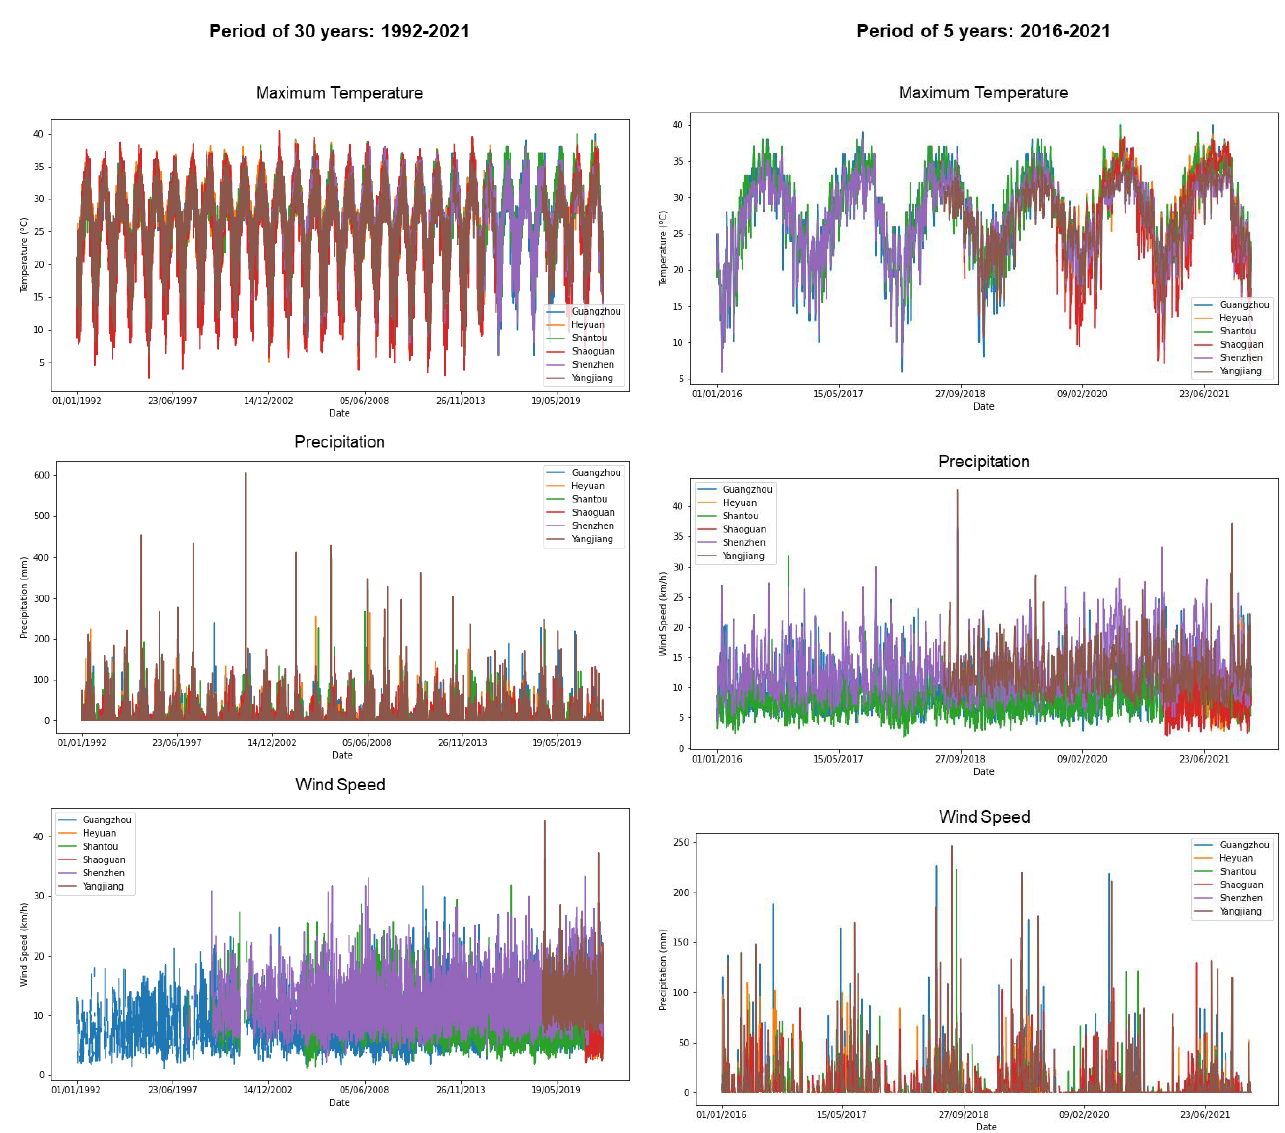
Figure 8. Trends of temperature, precipitation and windspeed in Guangzhou and the other five cities.